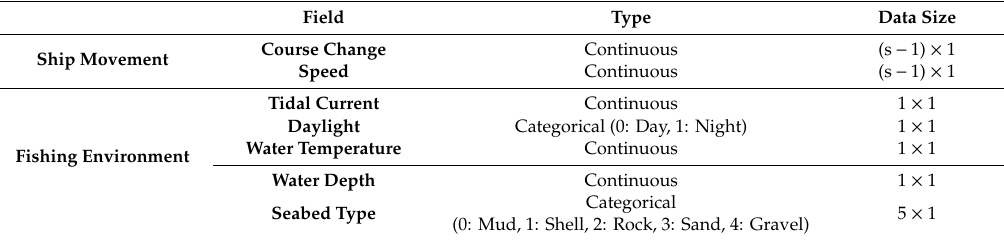
Table 2. Constitution of training data